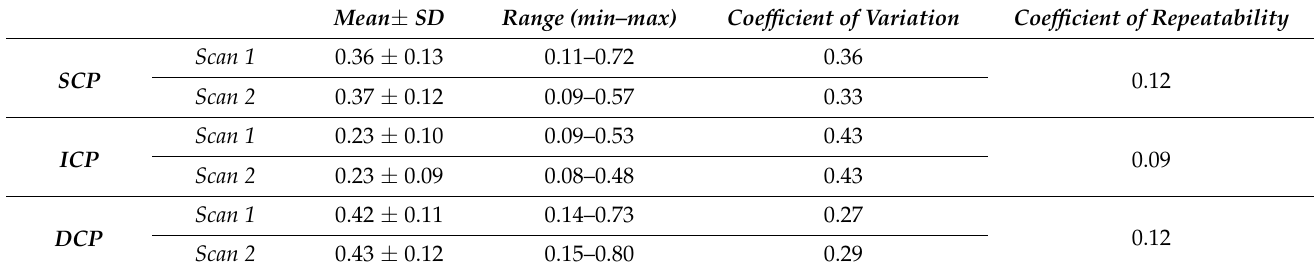
Table 1. Foveal avascular zone